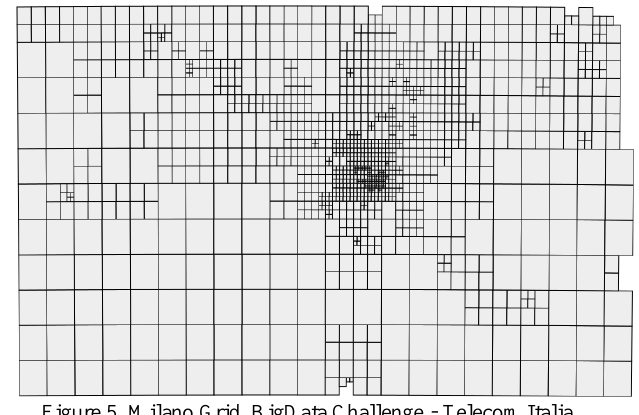
Figure 5. Milano Grid, BigData Challenge - Telecom Italia